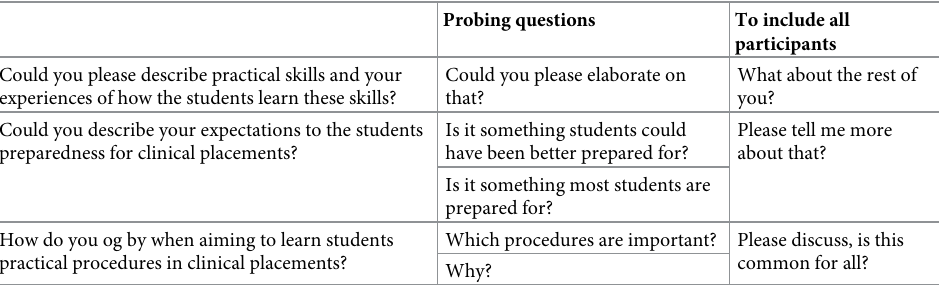
Table 1. Examples of questions from the interview